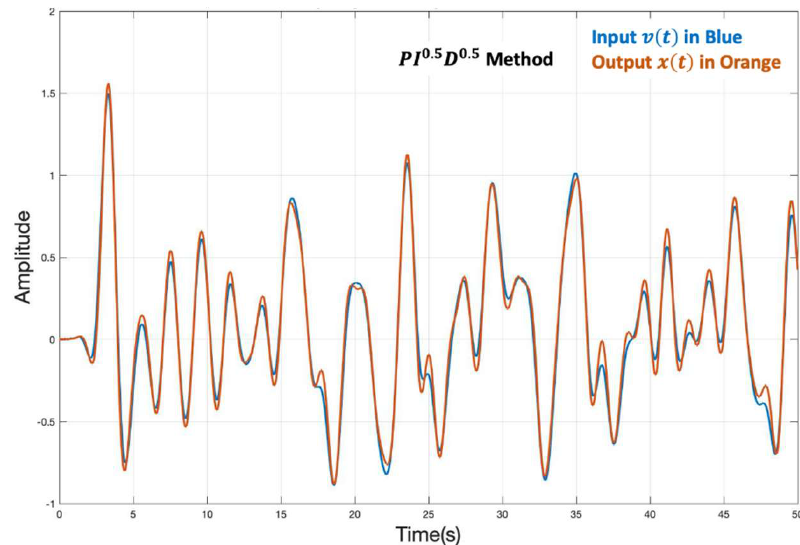
Figure 21. Response to Randomized Input (Technique 4).